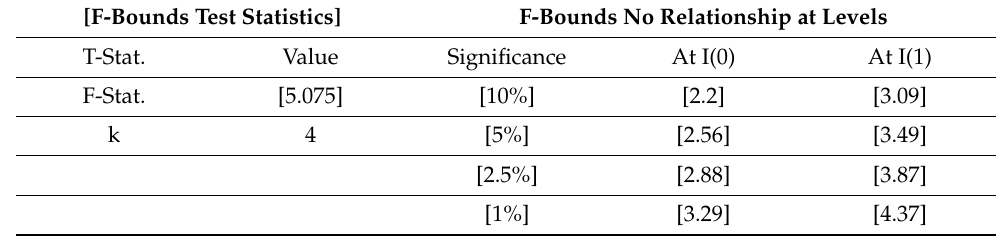
Table 7. Bounds test to